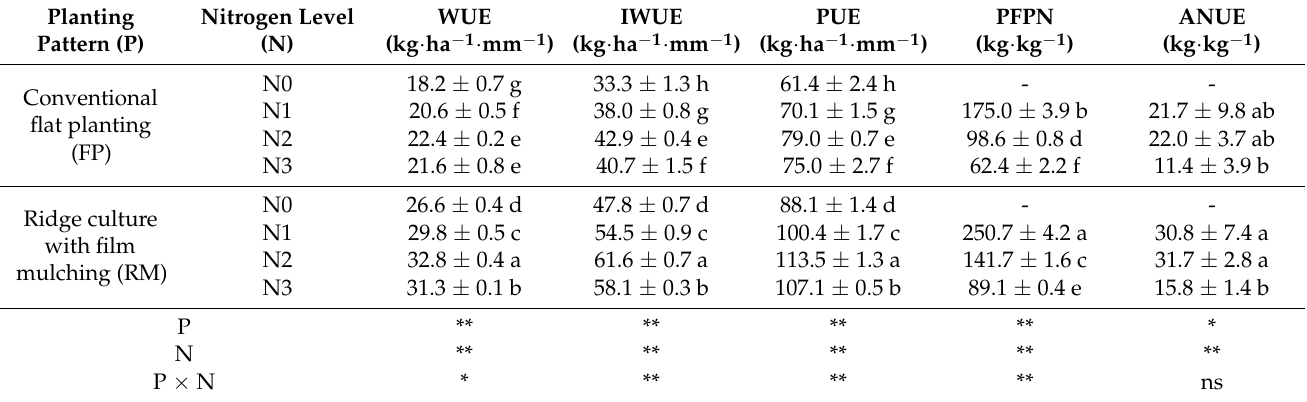
Table 5. Impact of planting pattern and nitrogen level on water–nitrogen use efficiency of